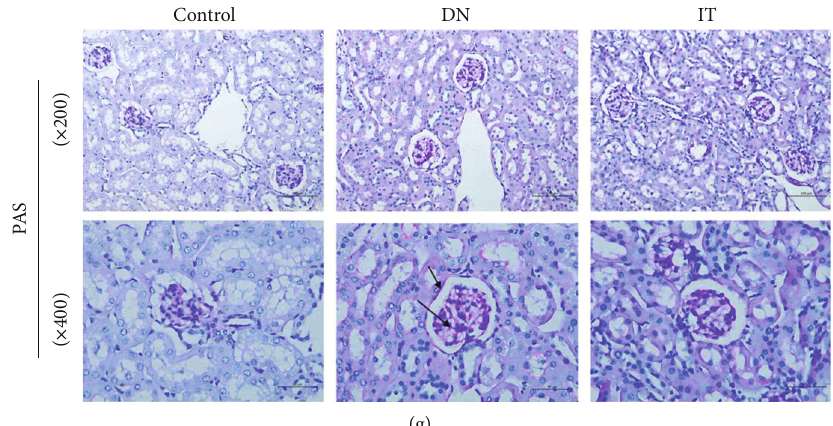
Figure 2: Improvement of body weight, blood glucose, renal function, and pathology in mice after islet transplantation. (a) Random blood glucose was measured once a week (islet transplantation model mice established at 18 weeks). (b) The weight of mice was recorded once a week. (c, d) Blood creatinine and urea nitrogen were measured for each group. (e) Urinary albumin-to-creatinine was measured for each group. (f, g) The HE and PAS staining of glomerular structure showed typical pathological changes (The arrow in HE points to the glomerular hypertrophy; the arrow in PAS points to the glomerular basement membrane thickening) ( ∗ P < 0 : 05 versus the control group, # P < 0 : 05 versus the DN